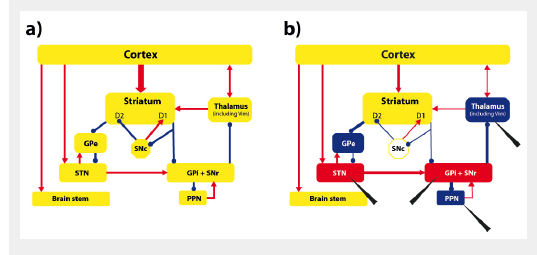
A simplified scheme of the basal-ganglia and thalamo-cortical network responsible for movement control (based on [39, 40]). Part a) shows the functional network, where red lines stand for excitatory and blue lines for inhibitory connections. Part b) shows the dysfunctional network resulting from a loss of dopaminergic neurons in the Substantia nigra pars compacta (SNc). Network nodes in red color indicate hyper-activation, nodes in blue color hypo-activation. D1/D2: sub-populations of neurons in the striatum; GPe: Globus pallidus externus; STN: Nucleus subthalamicus; GPi: Globus pallidus internus; SNr: Substantia nigra pars